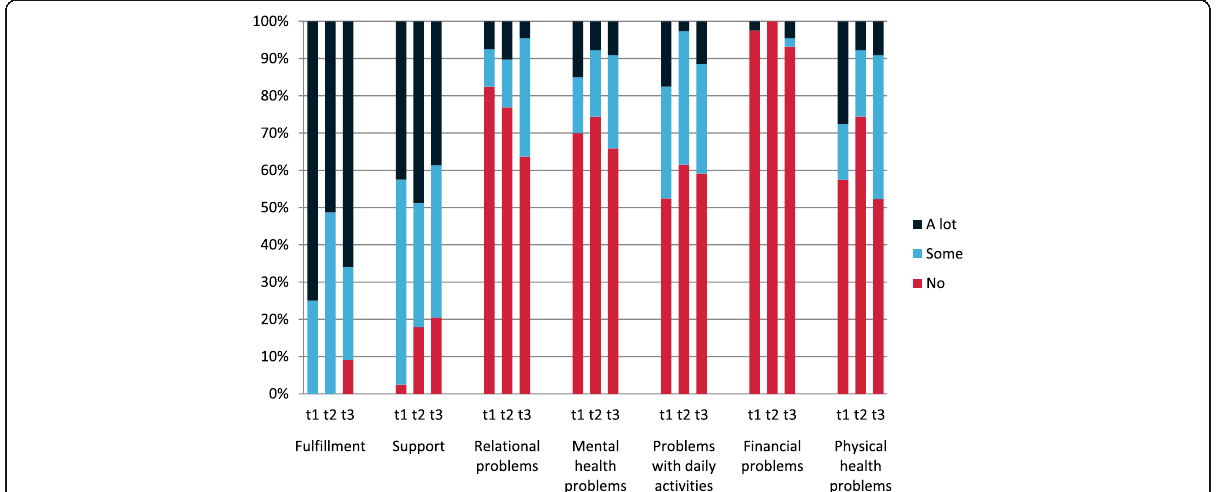
Fig. 1 Distribution of CarerQoL-7D – dimensions reported by informal caregivers providing informal care at 1, 3 and 6 months (t1,t2,t3) after hip